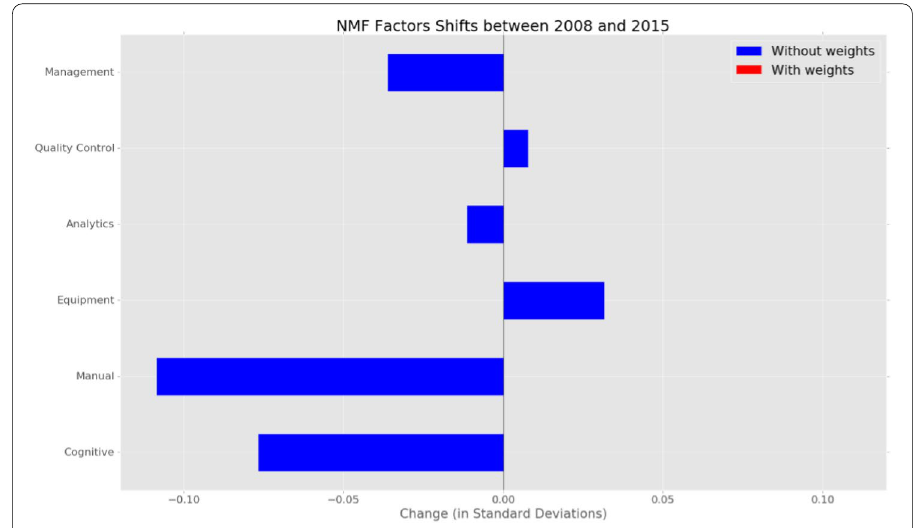
Fig. 11 NMF factors shifts between 2008 and